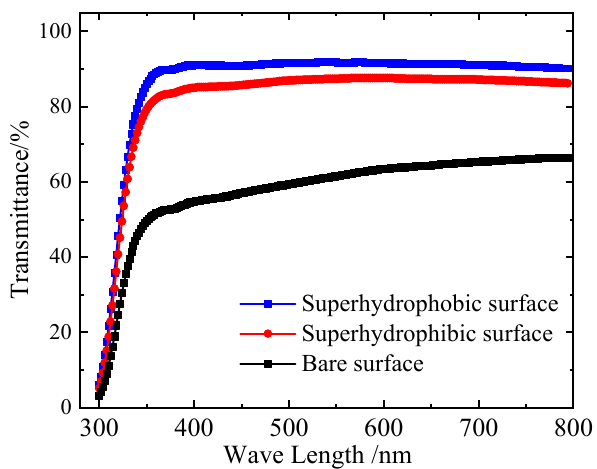
Figure 11. The spectral transmittance of glass samples after the process of water spraying. Figure 12. The spectral transmittance of glass samples after the process of water